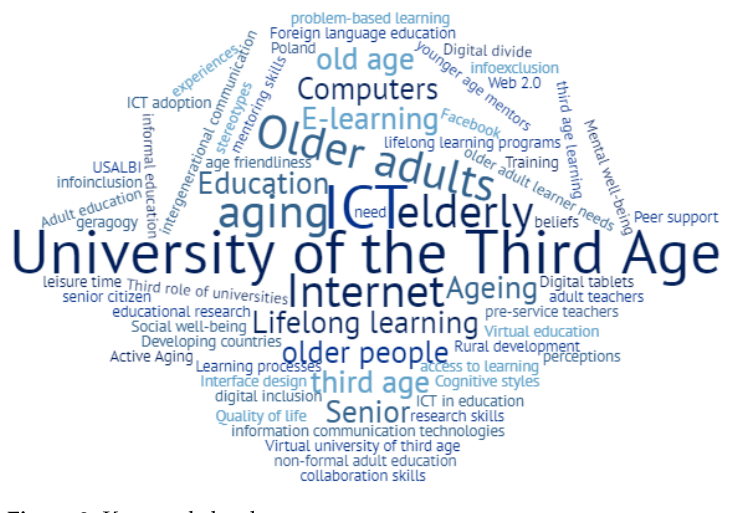
Figure 2. Keyword cloud.